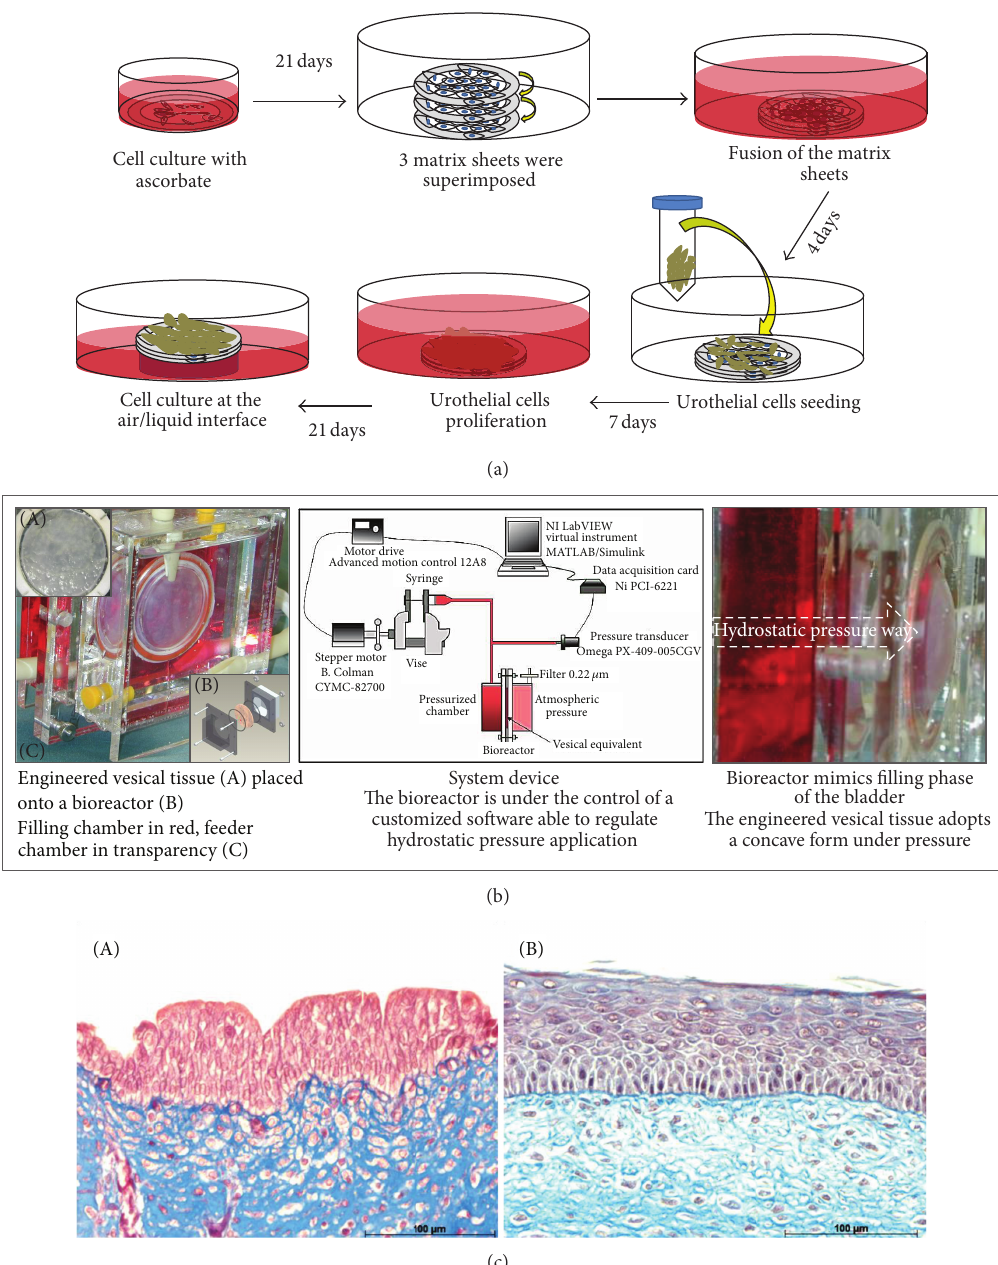
Figure 6: Production of a vesical equivalent by the self-assembly technique. Vesical equivalent reconstruction can be divided in two major steps. (a) Upper panel: deposition of extracellular matrix to create a manipulatable sheet followed by seeding of urothelial cells. (b) Middle panel: proliferation and differentiation of urothelial cells using a specially designed bioreactor. Bioreactor mimics filling and emptying phases of the bladder. Note that under pressure, vesical equivalent adopts a concave form. (c) Lower panel: self-assembly technique allows production of human reconstructed endothelialized vesical equivalent. (A) Masson’s trichrome staining of a slice from a native porcine bladder. (B) Masson’s trichrome staining of a slice from a human reconstructed vesical